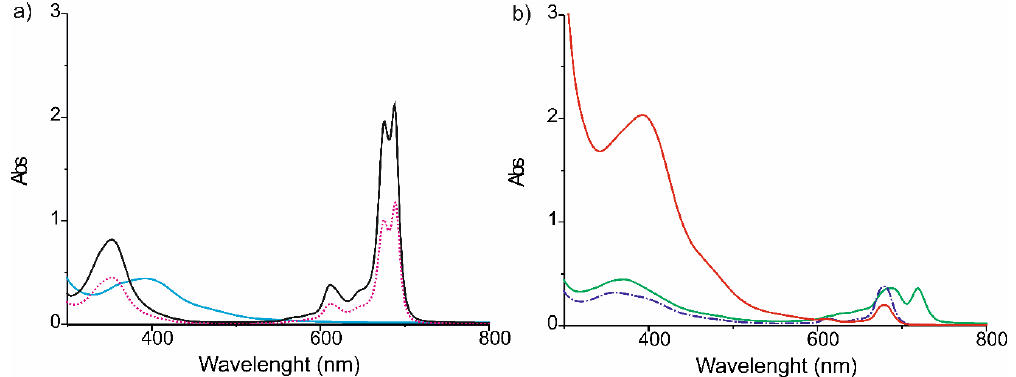
Figure 2. UV-Vis absorption spectra of ( a ) AuNP tOcBr (blue — ), ZnPc RS (pink ······), ZnPc R -S-ZnPc R (black—) and of ( b ) the mixture AuNP tOcBr / ZnPc RS (purple · – · – · ), the mixture AuNP tOcBr / ZnPc R -S-ZnPc R (green — ) and the covalent adduct AuNP tOcBr -S-ZnPc R (red — ), in toluene as solvent.